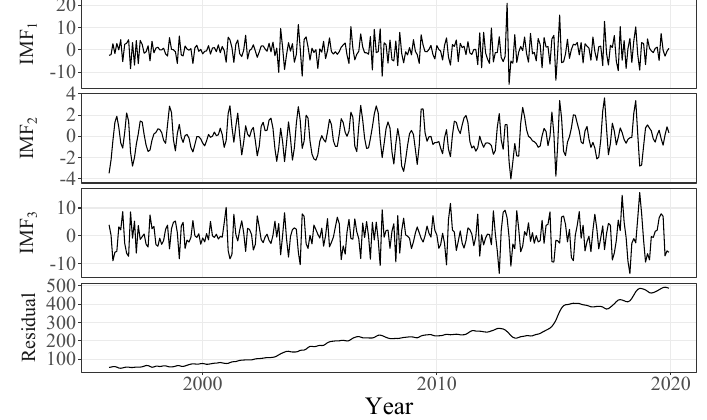
Figure 5. Decomposed series for industrial